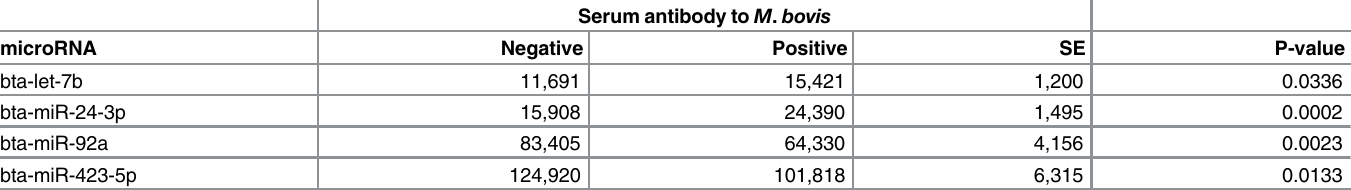
Table 2. MicroRNA, normalized mean for each microRNA ELISA status, standard error (SE), and their association (P-value). Serum antibody to M . bovis